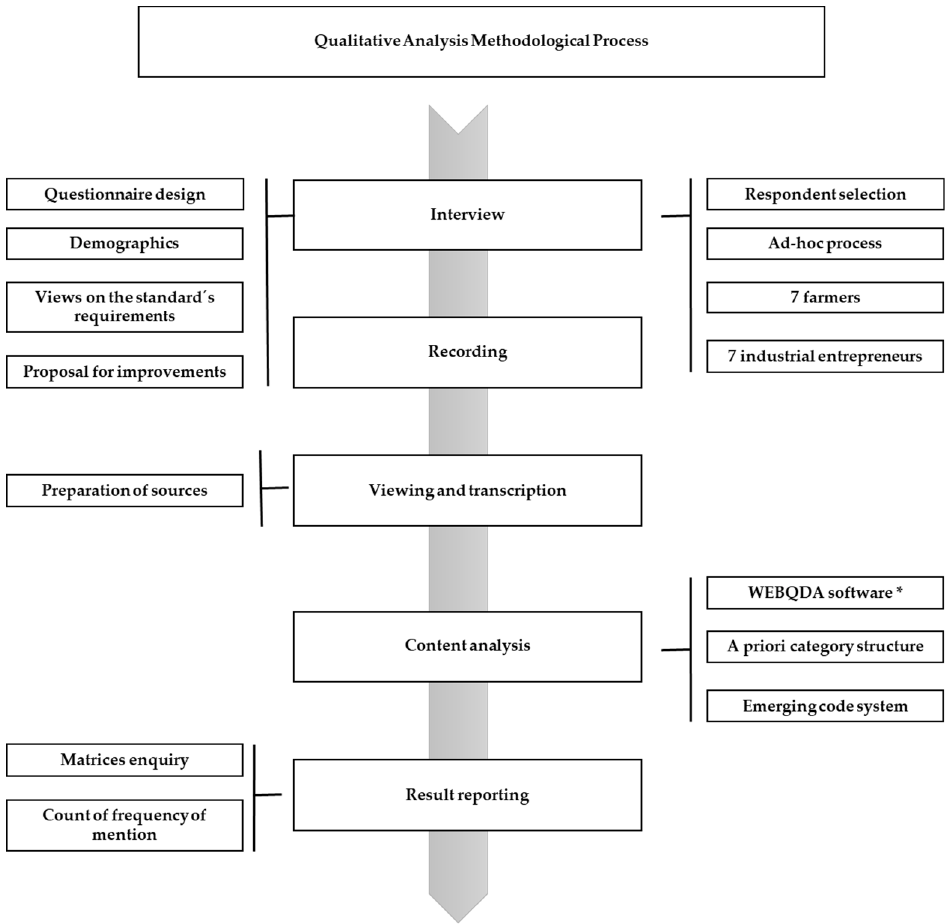
Figure 1. Methodological process followed in order to carry out the in-depth interviews. * WebQDA Software V 3.1. is a qualitative data software analysis. It allows editing, viewing, linking and organizing different sources as text documents or audio files. It can create categories, codes, manage, filter, search and question the data in order to answer the questions that emerge in the research. WebQDA Software has been developed by the partnership Universidade de Aveiro; CIDTFF; Esfera Cr í tica and Ludomedia (https: // www.webqda.net /